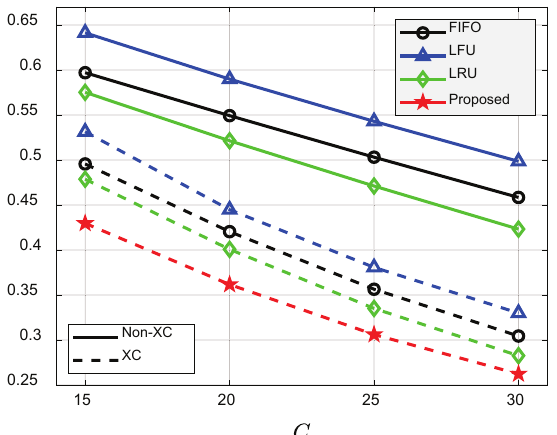
Figure 7. Average number of required transmissions for various C ’s. p = 0.001, ρ = 0.5, V = 100, N = 50, K = 10, and β = 1.